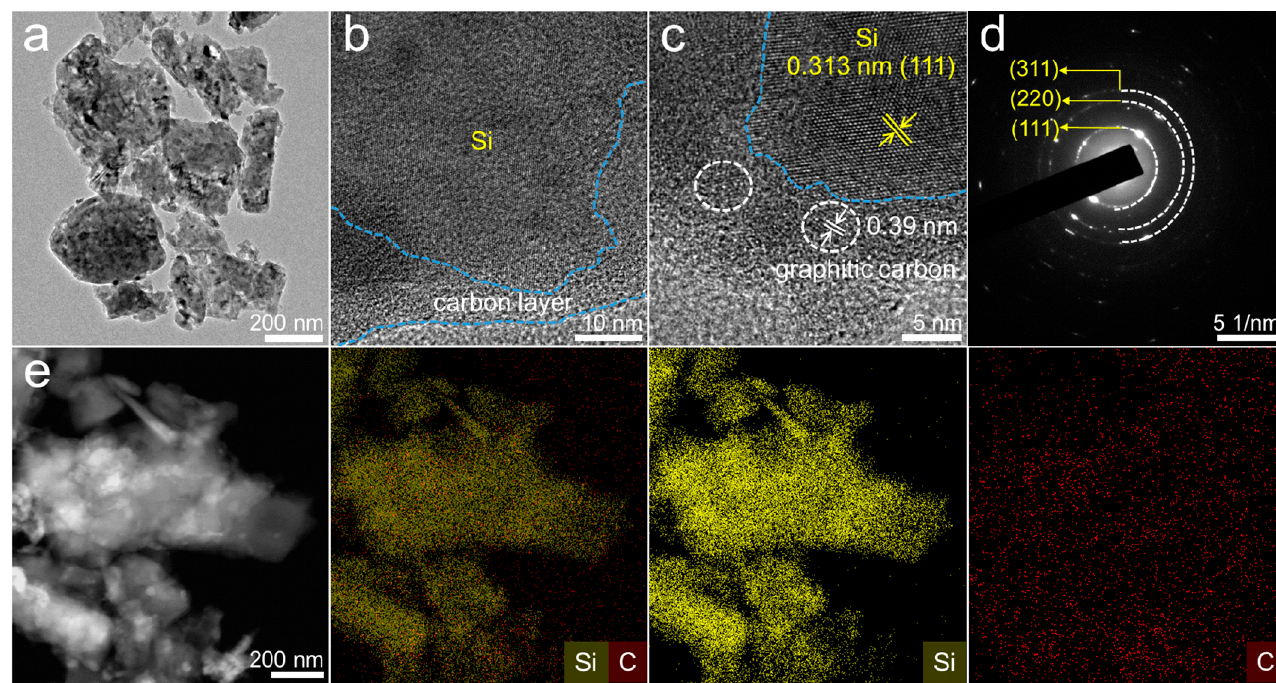
Figure 1. ( a ) TEM image, ( b , c ) HRTEM images, ( d ) SAED pattern, and ( e ) EDX elemental mapping of FP-Si@C-2.